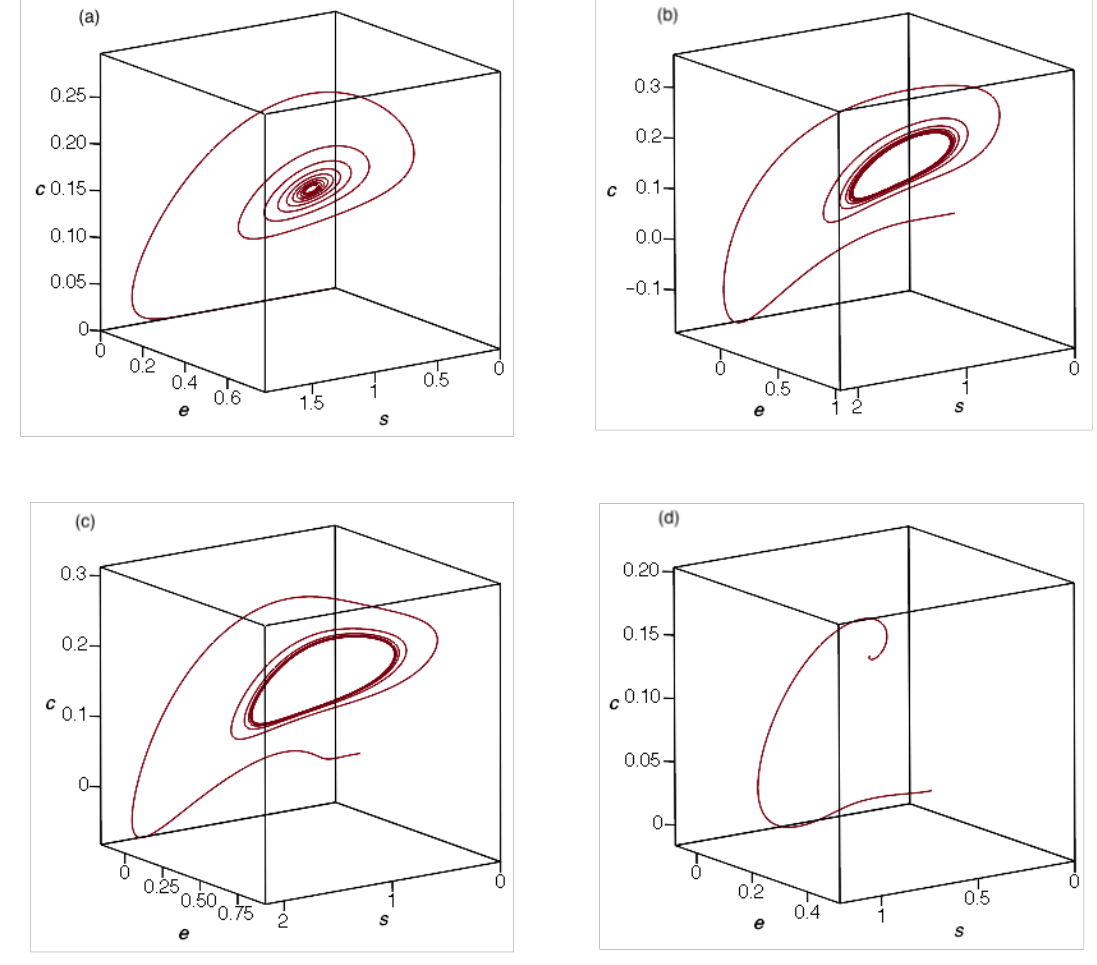
Figure 8. Trajectories of ( a ) the DDE inducible enzyme model, ( b ) the reduced model for m = 1, ( c ) the reduced model for m = 2, and ( d ) the reduced model for m = 3. For the reduced models, the k = 3 iterate was used. The parameters are the same as in Figure